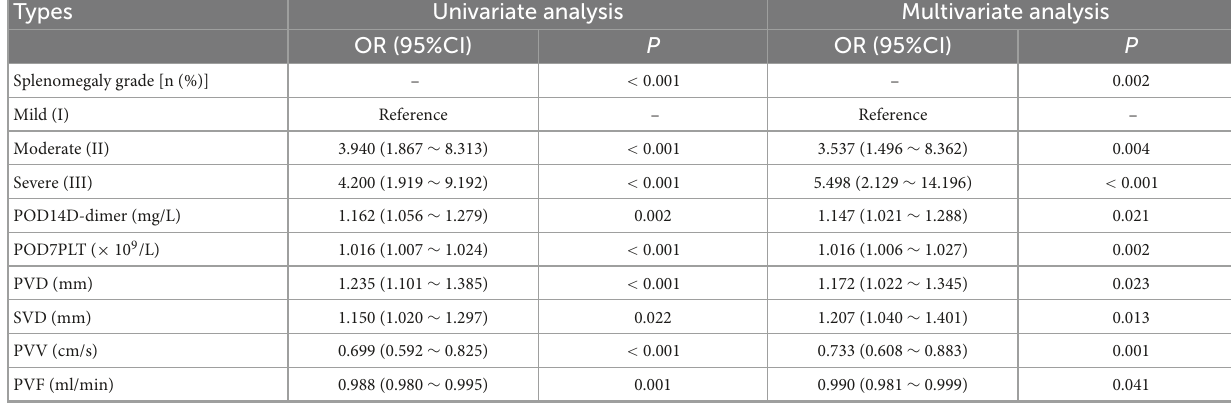
TABLE 2 Univariate and multivariate logistic regressions of influencing factors of portal venous system thrombosis (PVST) in the development